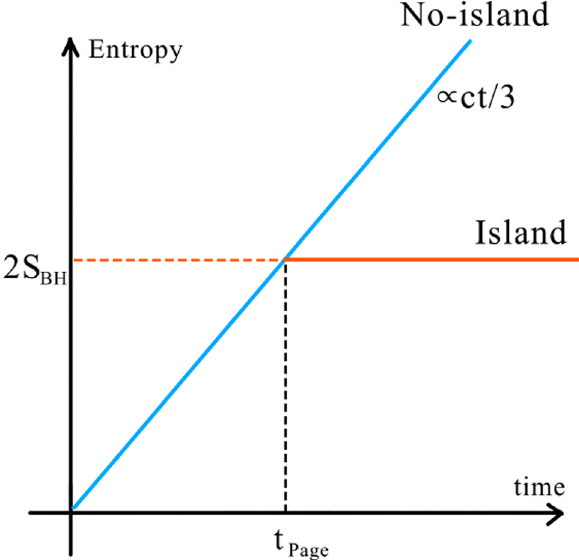
Figure 3 . The Page curve. The blue line is the entropy without islands, which increases eternally. After the Page time t Page ’ 6 (cid:12)S BH = 2 (cid:25)c , the one without islands becomes greater than the one with an island. Thus a phase transition occurs, and the entropy reaches a constant value, which is approximately twice of the black hole